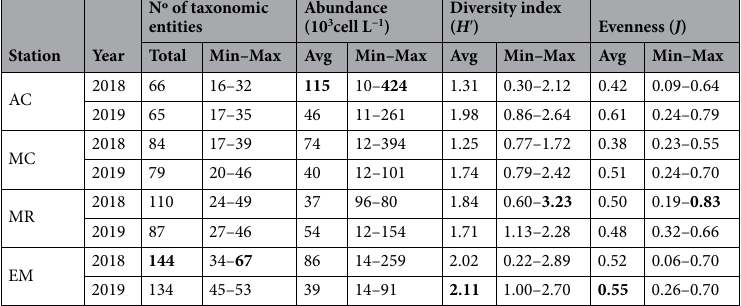
Table 2. Interannual variation of phytoplankton diversity in the different regions of Sado Estuary. Number of taxonomic entities: total of each year and minimum (Min) and maximum (Max) identified in one sample. Abundance (10 3 cell L −1 ), Shannon–Wiener diversity index (H’), and Evenness index (J): annual average (Avg) and minimum (Min) and maximum (Max) identified in one sample. Maxima values are shown in